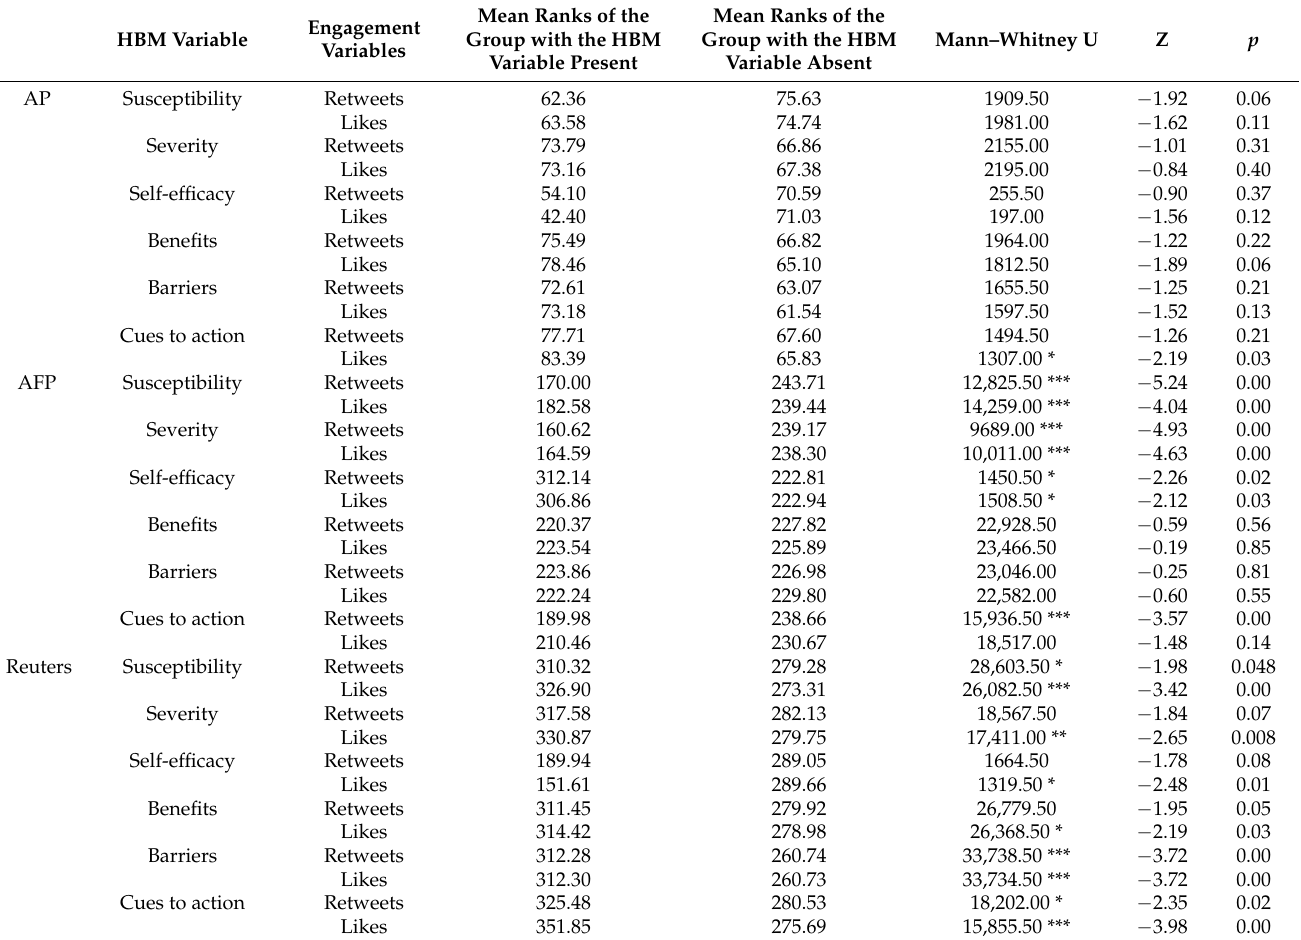
Table 5. HBM constructs and Twitter